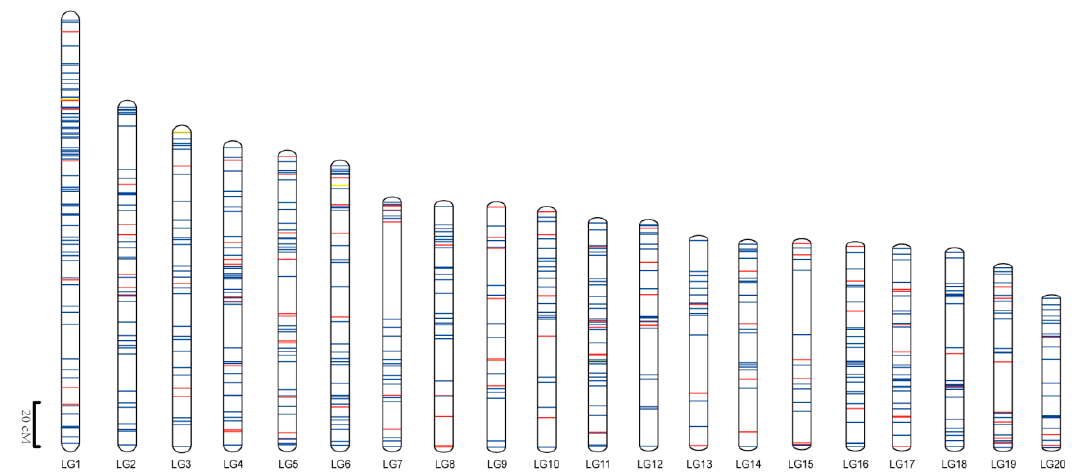
Figure 1. The linkage map of C. pepo constructed in this research. Blue, red, and yellow bars indicated the EST-SSR marker, gSSR marker developed from Cucurbita and gSSR marker developed from the cucumber genome, respectively. The scaleplate on the left indicated genetic distance (centimorgan as unit, abbreviated cM). LGs represented linkage groups, from LG1 to LG20. Table 1. Description of the 20 linkage groups (LGs) in Cucurbita pepo .